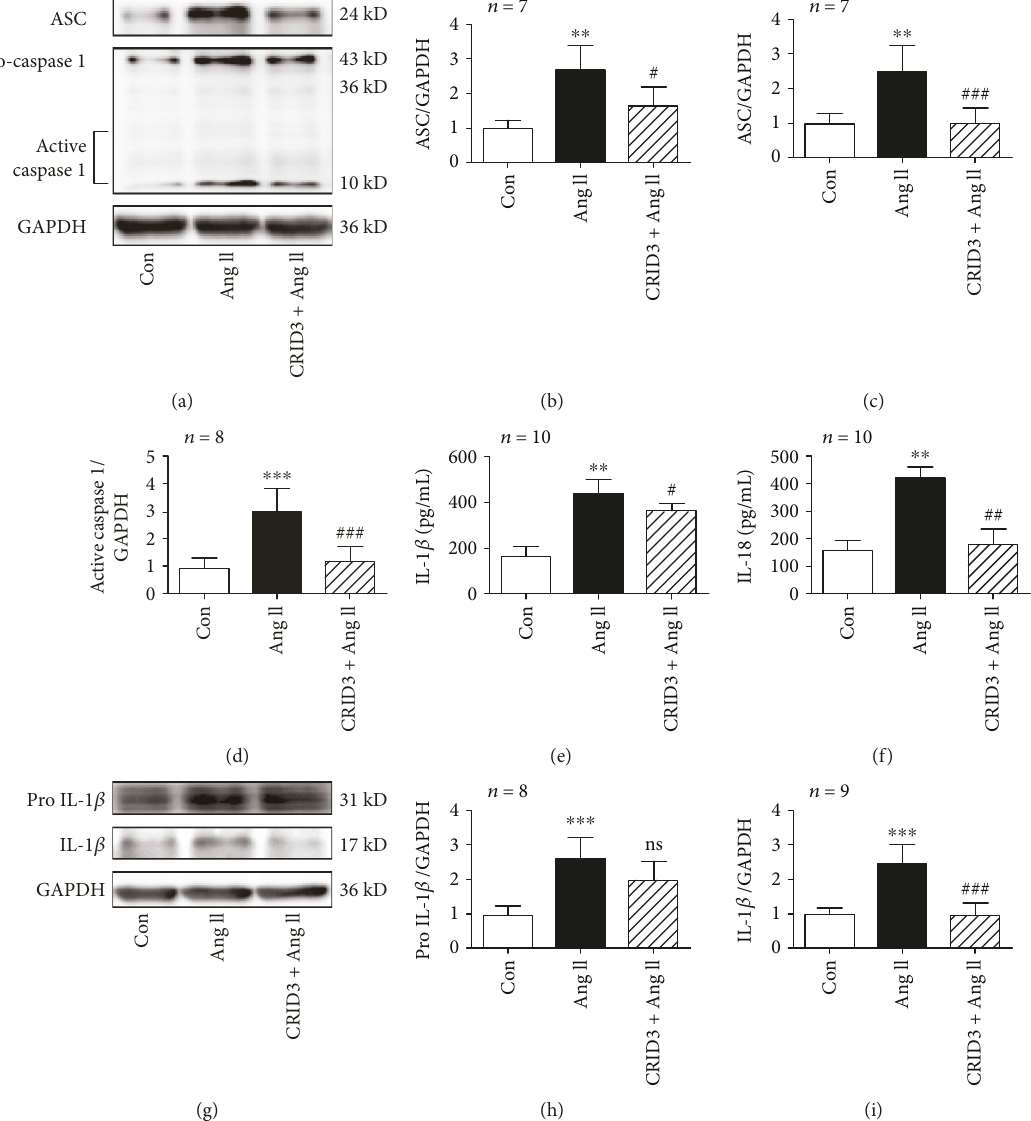
Figure 6: CRID3 inhibited the formation of NLRP3 in fl ammasomes and production of IL-1 β and IL-18 in VSMCs stimulated with Ang II. (a) CRID3 (25 μ M) pretreatment for 30min prevented increase in ASC and caspase 1 induced by Ang II. The analysis tables are shown in (b – d). (e, f) IL-1 β and IL-18 in supernatants were analyzed by ELISA. Protein expressions of pro-IL-1 β and IL-1 β in VSMCs detected by western blot are shown in (g). (h, i) Bar graphs showed increased expression of pro-IL-1 β and IL-1 β induced by Ang II. CRID3 prevented the release of mature IL-1 β , but failed to decrease pro-IL-1 β . ∗∗ P < 0 01 and ∗∗∗ P < 0 001 vs. control; # P < 0 05 , ## P < 0 01 , ### P < 0 001 , and ns P > 0 05 vs. Ang